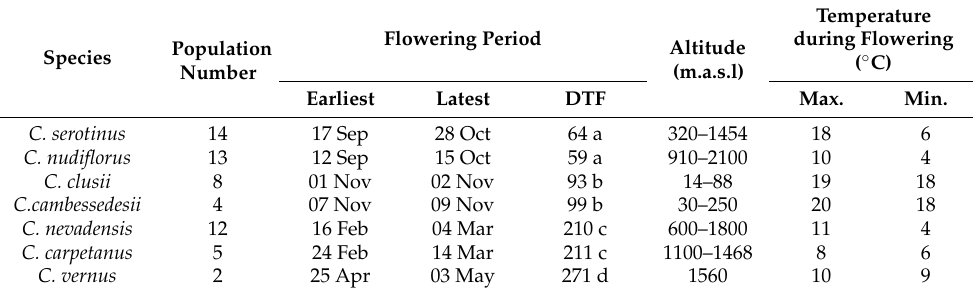
Figure 1. Areas of collection and altitude of distribution of seven wild Crocus species in Spain, as presented in the Documentation System of the BGV of Crocus [19]. Table 2. Flowering time and environmental data of 58 native populations of seven Spanish crocus species. Days from August 1st to flowering (DTF, Mean value) are calculated for the comparison with common garden